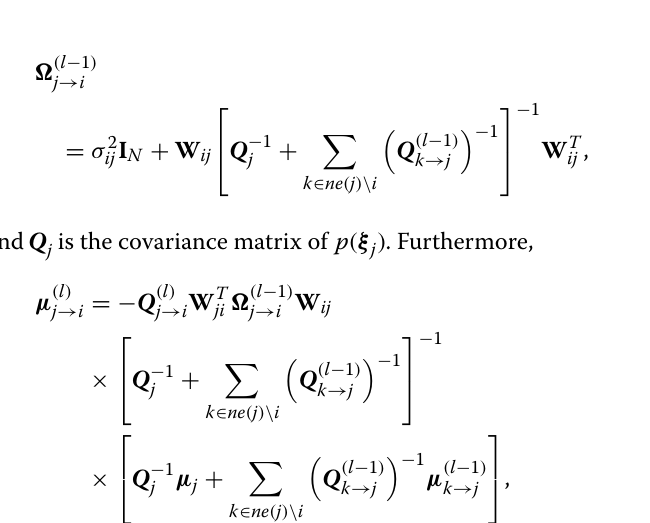
Fig. 6 (cid:31) i → j = (cid:31) p and (cid:31) j → i = (cid:31) p are the BP messages exchanged between physical nodes in ij → ξ i ij → ξ j